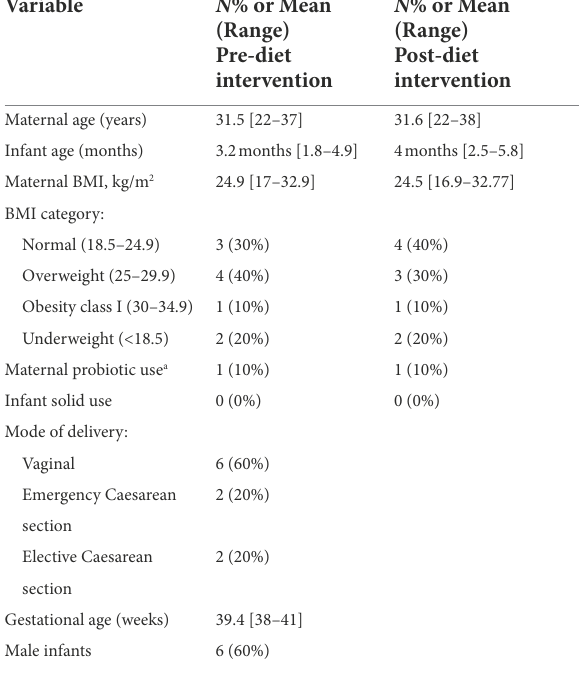
TABLE 3 Participant characteristics ( n =